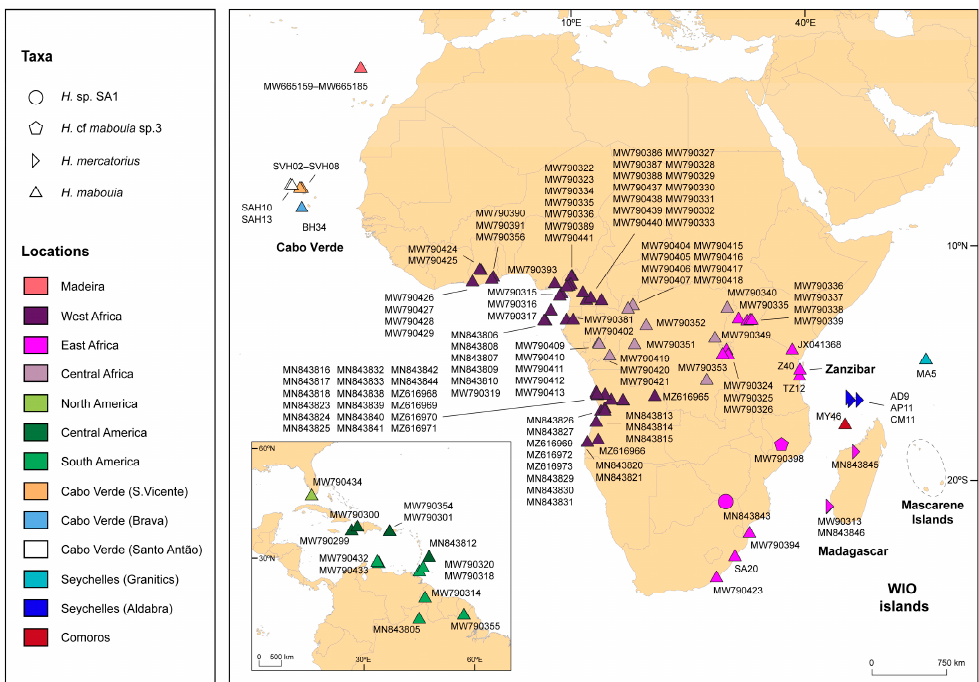
Figure 1. Map representing the geographical location of the samples used in this study for both 12S and ND2 markers. The bottom left corner represents samples from the Americas. Samples obtained from GenBank are represented by accession numbers, and samples obtained in this study are represented by tissue codes. Different symbols represent the different taxa and are coloured according to location. For further details, please check Table S1.